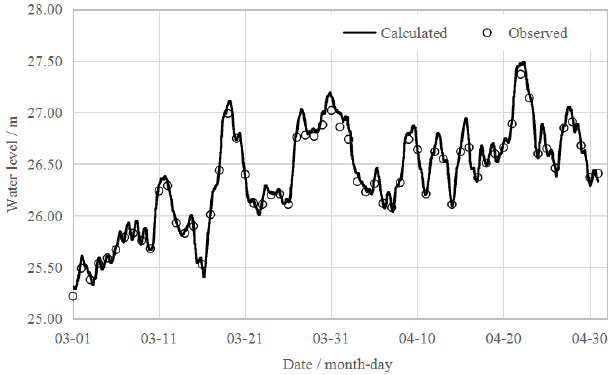
Figure 6. Water level process of forecasting and observed at down- stream transverse cofferdam in March and April